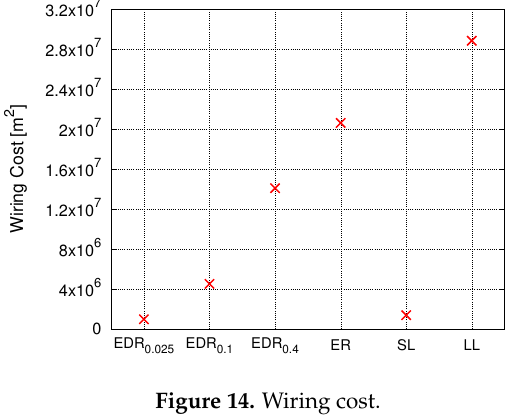
Figure 14. Wiring